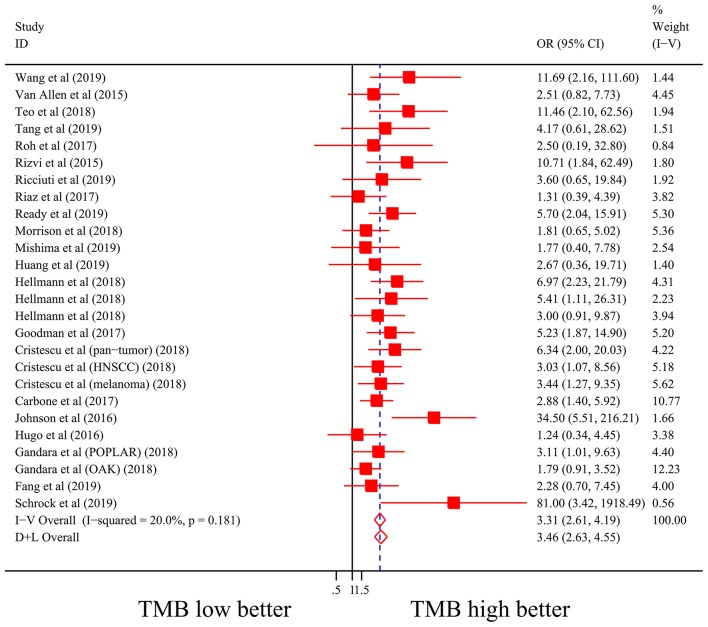
Forest plot of association between TMB and objective response rate of immune checkpoint inhibitors. OR, odds ratio; CI, confidence interval; TMB, tumor mutation burden.